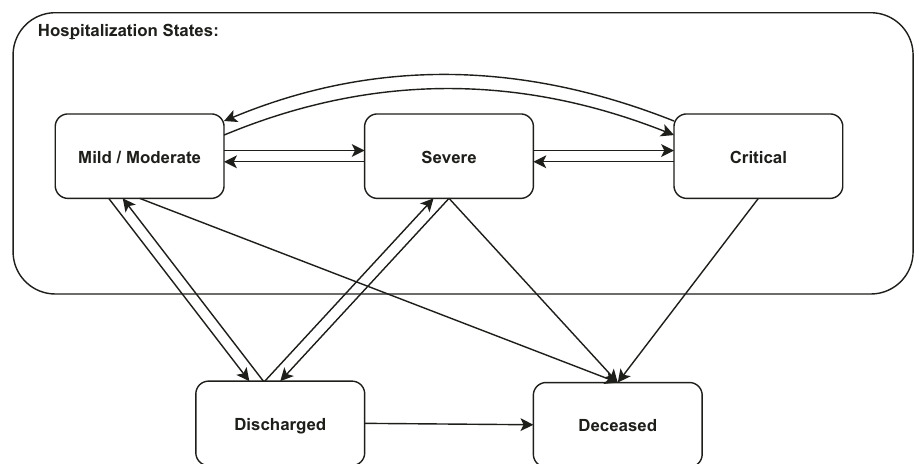
Fig. 3 Multistate model. Patients disease course transitions between 5 possible clinical states: mild or moderate, severe, critical, discharged, and deceased. Each transition was modeled using a set of Cox regression models, adjusting for right censoring, recurrent events, competing events, left truncation, and time-dependent